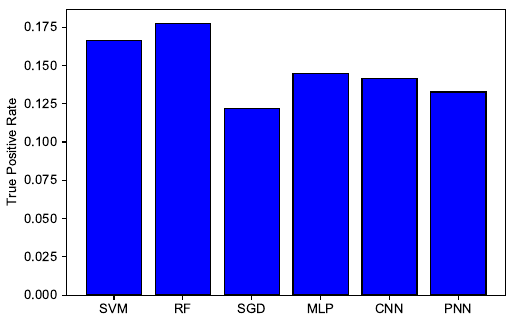
Figure 11. TPR of SVM, RF, SGD, MLP, CNN, and